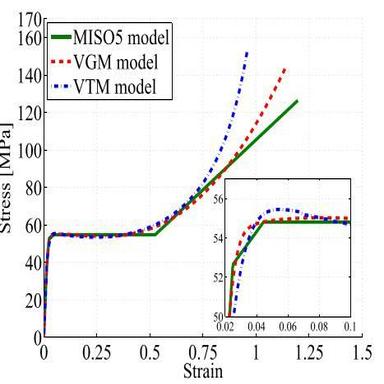
Constitutive response of MISO5, VGM and VTM models for the best fitting of force f F .